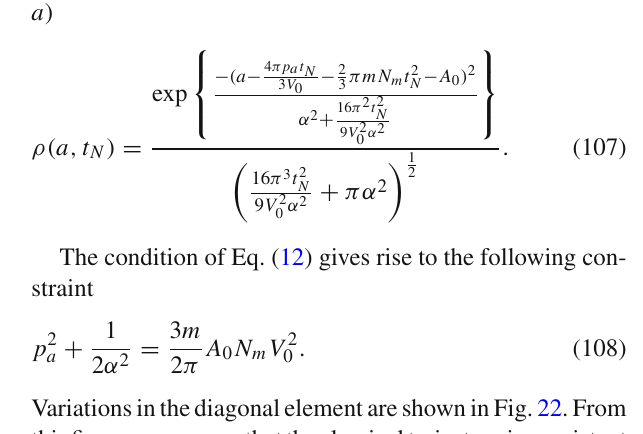
Fig. 22 Variations in the probability distribution of the scale factor. The horizontal and vertical axes represent the scale factor and time variable, respectively. The black curve shows the evolution for the clas- sical trajectory of the universe. The parameters are taken as: α = 1,